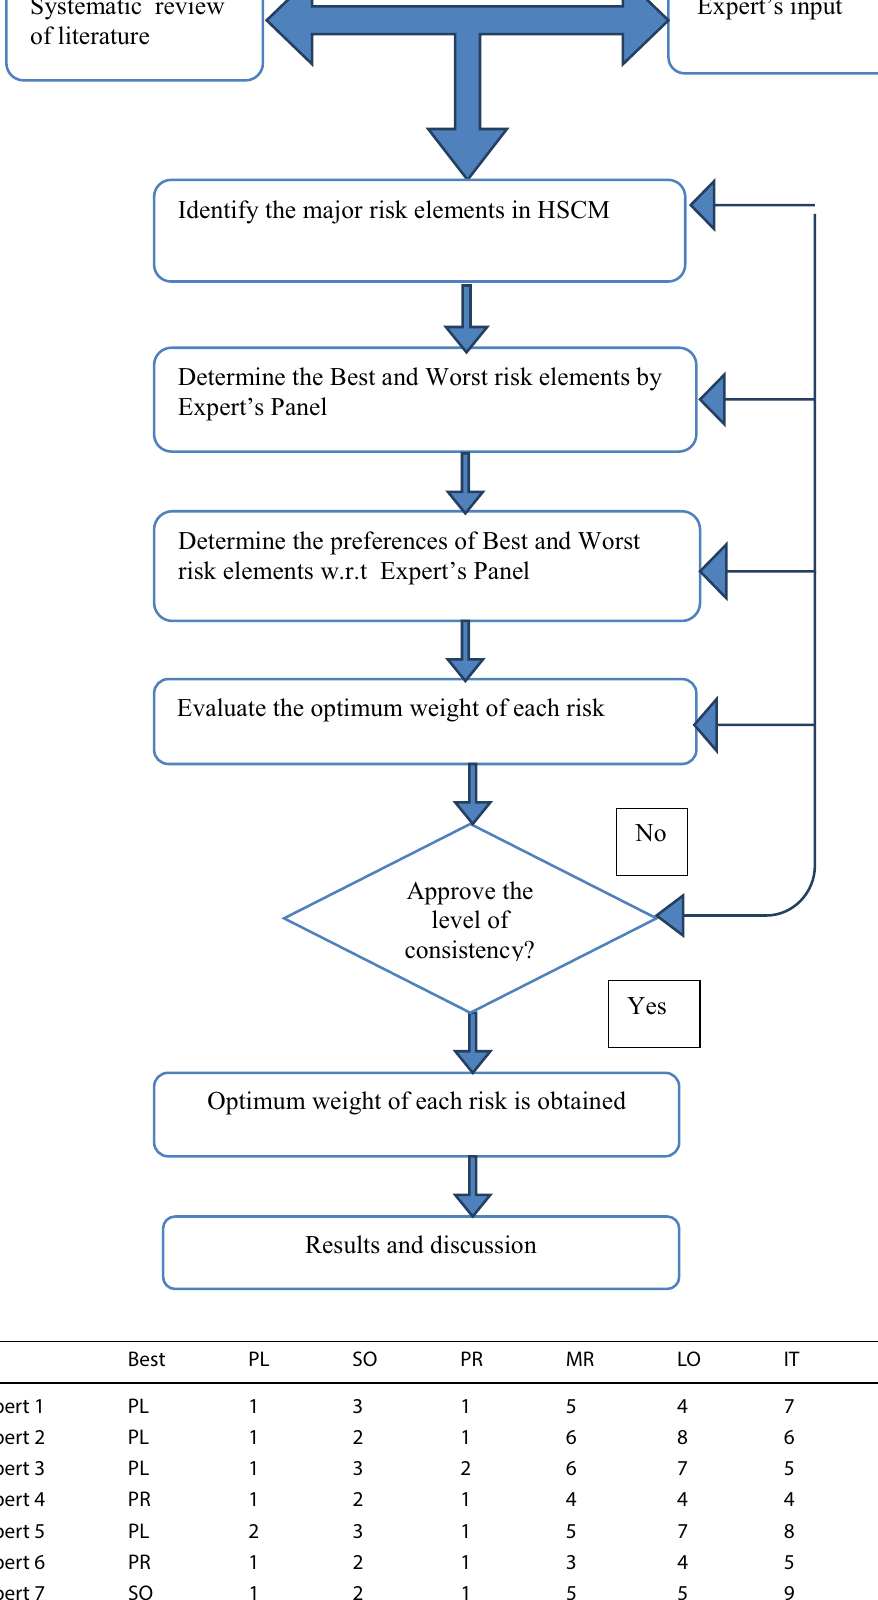
Fig. 1 Methodological frame- work for research